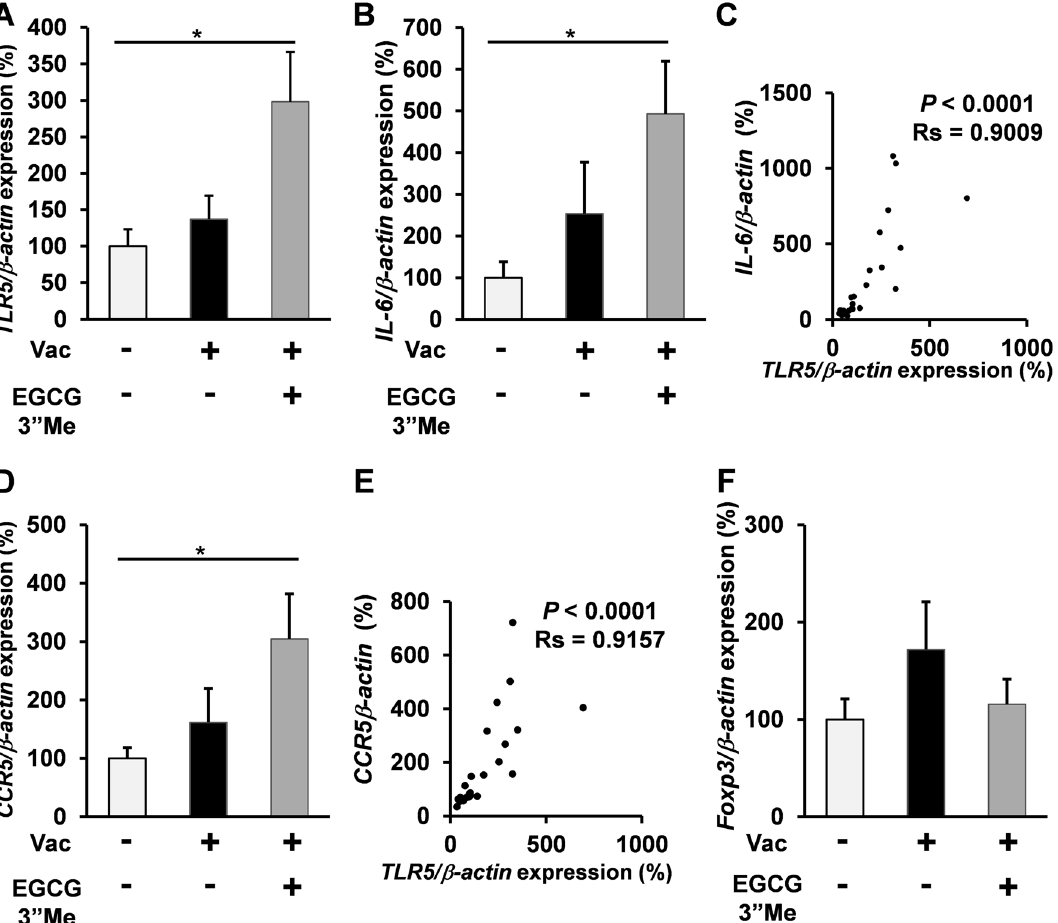
Figure 4. EGCG3”Me intake enhanced TLR5/IL6 expression in the intestine of split-virus vaccine-treated mice. ( A – F ) 12-week-old female BALB/c mice were fed AIN-93G diet or AIN-93G diet supplemented with 0.01% EGCG3”Me (EGCG3”Me 20 mg/kg body weight) for 5 weeks. Mice were treated with split-virus vaccine (1 μg HA/mouse i.d.) at 2 and 4 weeks. Mice were sacrificed at 5 weeks, and their intestines were harvested and evaluated for ( A , B ) TLR5 and IL6 expression by RT-qPCR (n = 8). ( C ) Correlation was analyzed by Spearman’s rank test (n = 24). ( D ) CCR5 expression was determined by RT-qPCR (n = 8). ( E ) Correlation was analyzed by Spearman’s rank test (n = 24). ( F ) Foxp3 expression was determined by RT-qPCR (n = 8). Data are presented as means ± SEM * P <